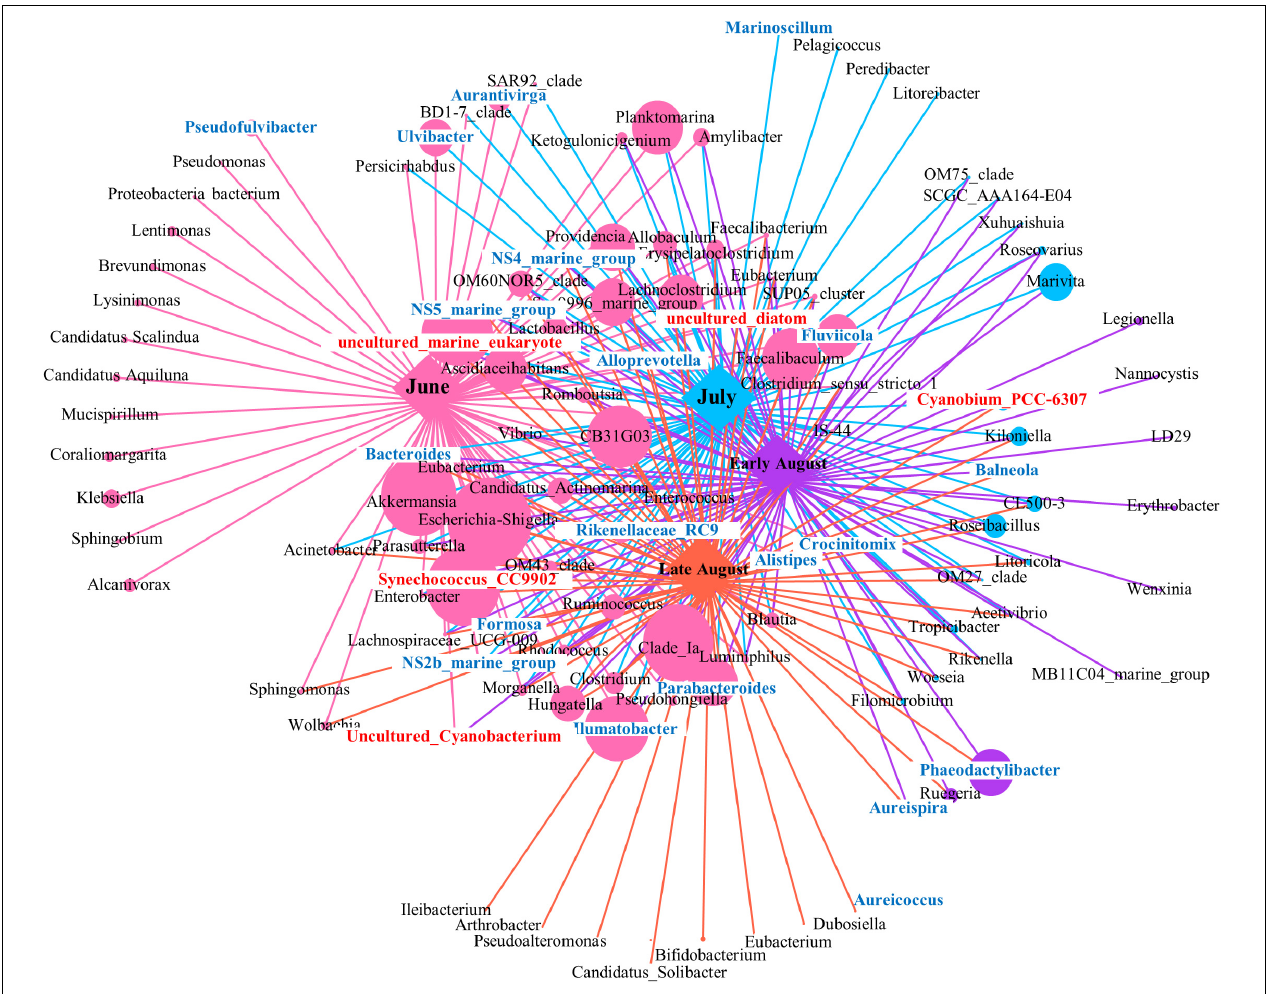
FIGURE 7 | The network co-occurrence shows correlations between phototrophic and heterotrophic bacteria along the succession of sampling time. Genus of Cyanobacteria was presented in red front, and genus of Bacteroides was presented in blue front.